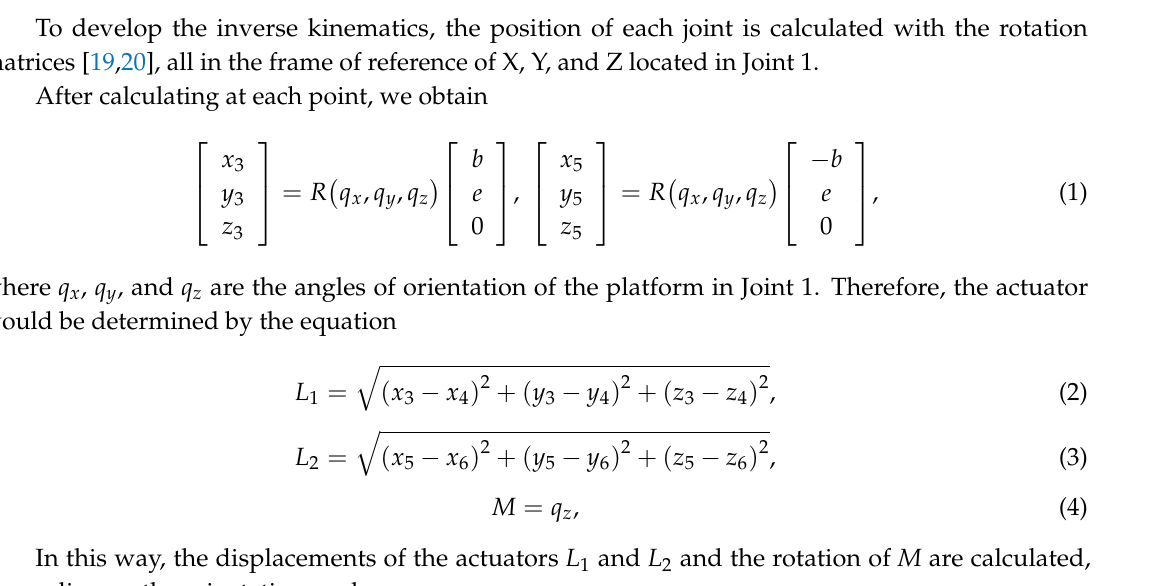
→ r is the vector of the center of the